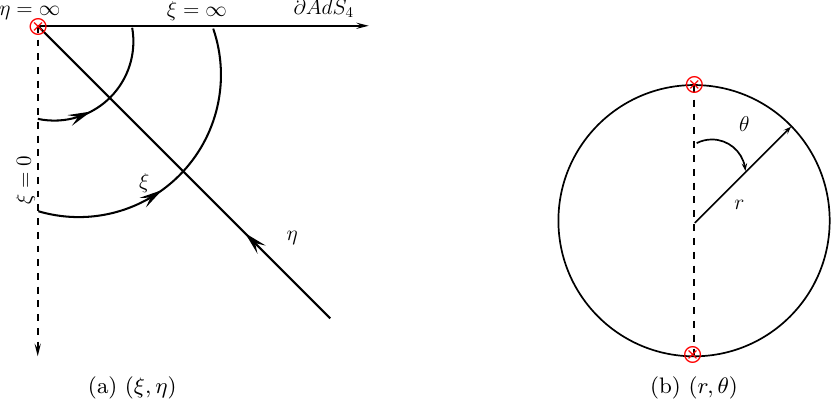
Figure 5 . (a) Depiction of the geometry in the coordinates of eqs. (5.8) and (5.9), at (cid:12)xed ( (cid:28); ’ ). The metric has a conical singularity at (cid:24) = 0 (dashed line), and is asymptotically AdS 4 at large (cid:24) . (b) Depiction of the geometry in global coordinates at (cid:12)xed ( t; ’ ), see eqs. (5.16) and (5.17). The conical singularity now extends along the diameter of the sphere (dashed